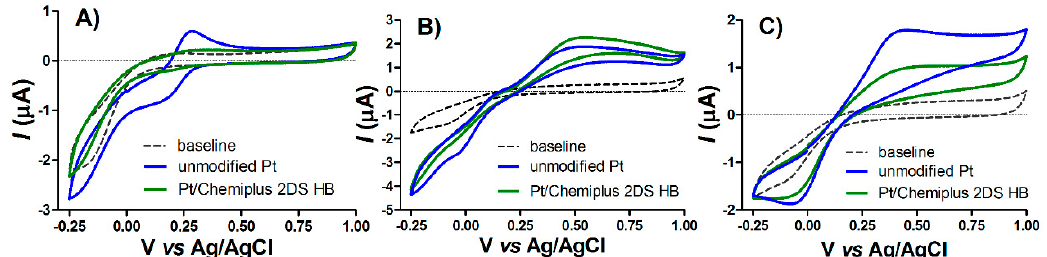
Figure 2. Cyclic voltammograms (range: − 0.25 until 1 V) performed on unmodified Pt electrodes (blue lines) and sensor modified with Chemiplus 2DS HB (green lines) at a scan rate of 100 mV/s using different electrochemical probes: 1 mM K 3 [Fe(CN) 6 ] in 0.1 M KCl as electrolyte ( A ); 1 mM of H 2 O 2 ( B ) and 1 mM of ascorbic acid ( C ) in 50 mM phosphate buffer as electrolyte.